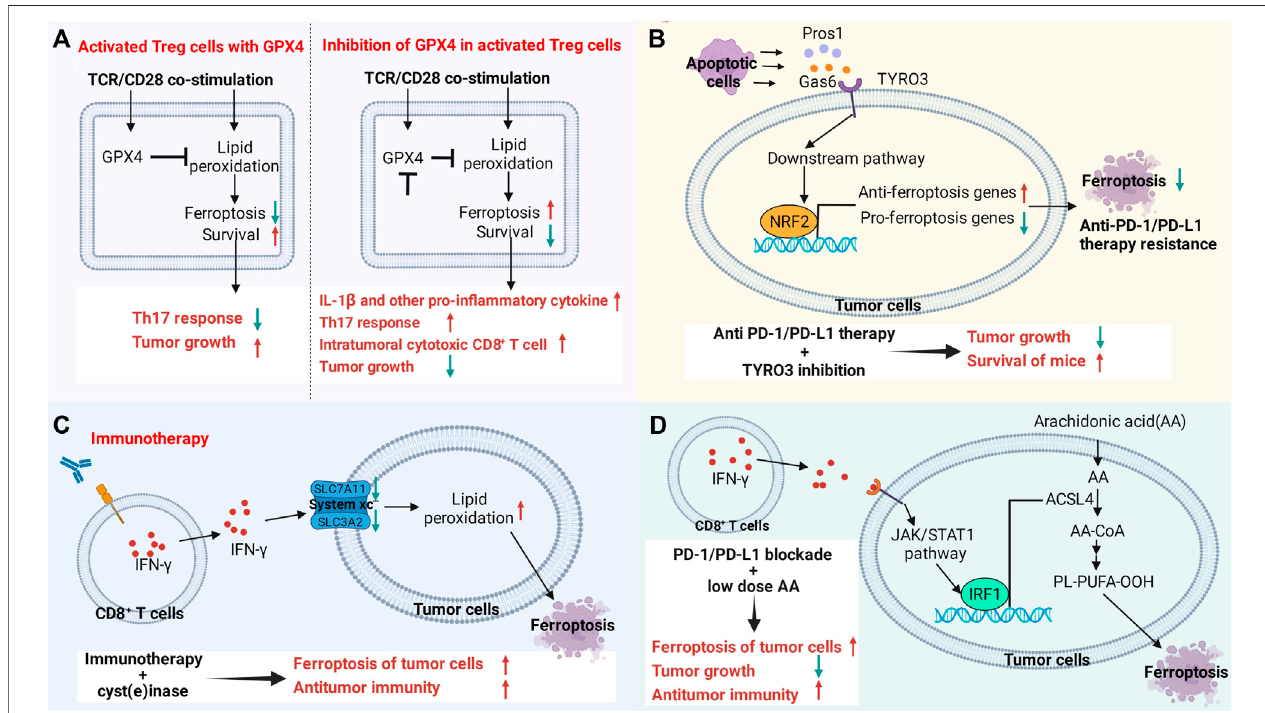
FIGURE 4 | Targeting the ferroptosis pathway in immune cells or cancer cells reverses immunotherapy resistance or enhances therapeutic ef fi cacy. (A) The ferroptosis signaling pathway in immune cells regulates antitumor immune function. Gpx4 protects activated Treg cells from lipid peroxidation and ferroptosis. Loss of Gpx4 leads to excessive accumulation of lipid peroxides and ferroptosis of Treg cells after TCR/CD28 co-stimulation. Gpx4-de fi cient Treg cells upregulate the production of IL-1 β and TH17 responses, increasing the number and killing activity of intratumoral CD8 + T cells. Knockdown of Gpx4 in Treg cells inhibited tumor growth and simultaneously enhanced antitumor immunity. (B) TYRO3 expressed by tumor cells leads to resistance to anti-PD-1/PD-L1 therapy by inhibiting tumor ferroptosis. Some molecules produced by apoptotic cells in the tumor microenvironment activate the AKT/NRF2 axis after binding to TYRO3, thereby promoting the transcription of ferroptosis-inducing genes and inhibiting the expression of ferroptosis-inducing genes, leading to anti-PD-1/PD-L1 therapy resistance. Inhibition of TYRO3 promotes tumor ferroptosis and sensitizesresistant tumorstoanti-PD-1 therapy. (C,D) CD8 + Tcell-derivedIFN- γ inthe tumor microenvironment promotes lipid peroxidation and ferroptosis in tumor cells. Drugs that promote ferroptosis enhance the antitumor ef fi cacy ofimmunotherapy. (C) IFN- γ promotes lipid peroxidation and ferroptosis in tumor cells by inhibiting the expression of SLC3A2 and SLC7A11. (D) IFN- γ activates the JAK/STAT1 signaling pathway in tumor cells, which in turn promotes the expression of ACSL4 through interferon regulatory factor 1 (IRF1). Supplementation with low-dose AA promotes ferroptosis in tumor cells and enhances the antitumor activity of checkpoint